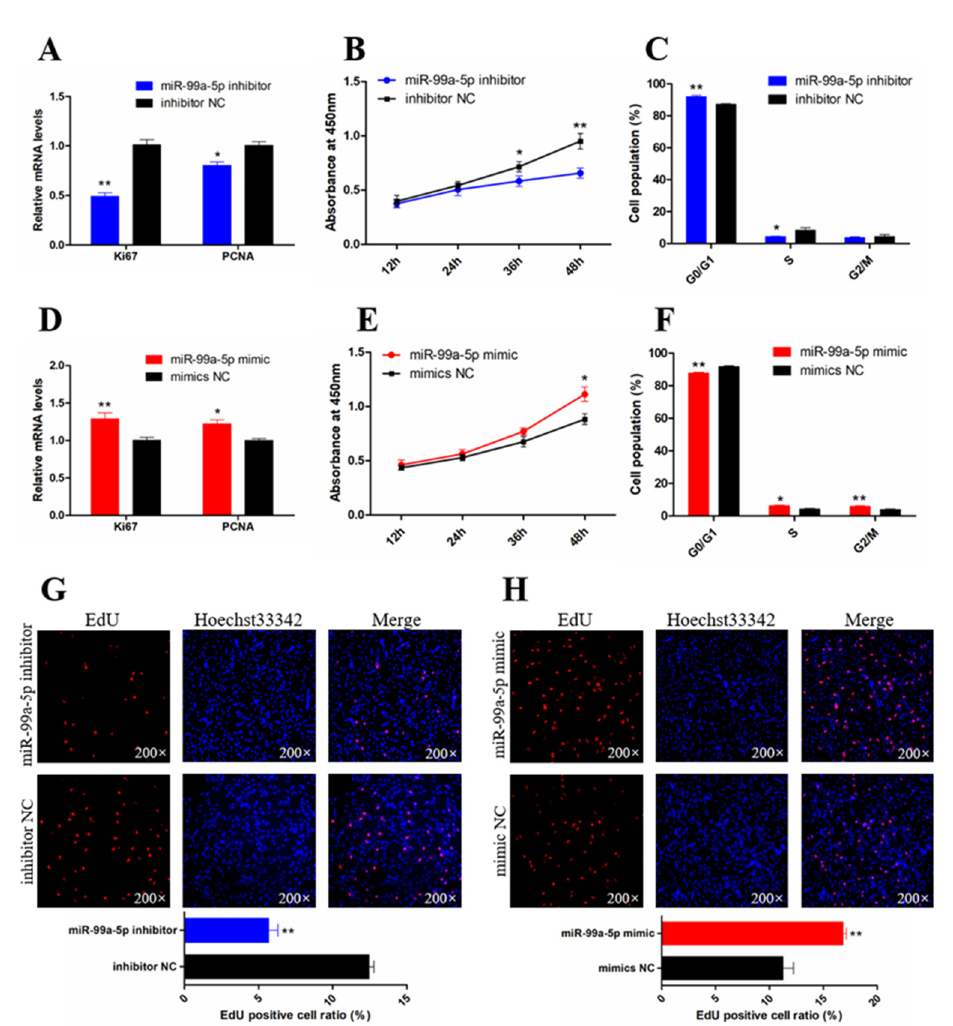
Figure 2. miR-99a-5p promotes the proliferation of chicken skeletal muscle satellite cells (SMSCs). ( A , D ) The mRNA levels of cell proliferation-related genes were detected by qRT-PCR in SMSCs after overexpression and inhibition of miR-99a-5p. ( B , E ) Cell counting kit 8 (CCK-8) assays for SMSCs after overexpression and inhibition of miR-99a-5p. ( C , F ) The statistical results of cell cycle analysis for SMSCs after overexpression and inhibition of miR-99a-5p. ( G , H ) EdU staining after the transfection of miR-99a-5p mimic and inhibitor in SMSCs (upper panels). Proliferation rates of chicken SMSCs following miR-99a-5p overexpression and inhibition (lower panels). Results are shown as mean ± SEM, and the data are representative of at least three independent assays. Student’s t -test was used to compare expression levels among di ff erent groups. * p < 0.05; ** p < 0.01.